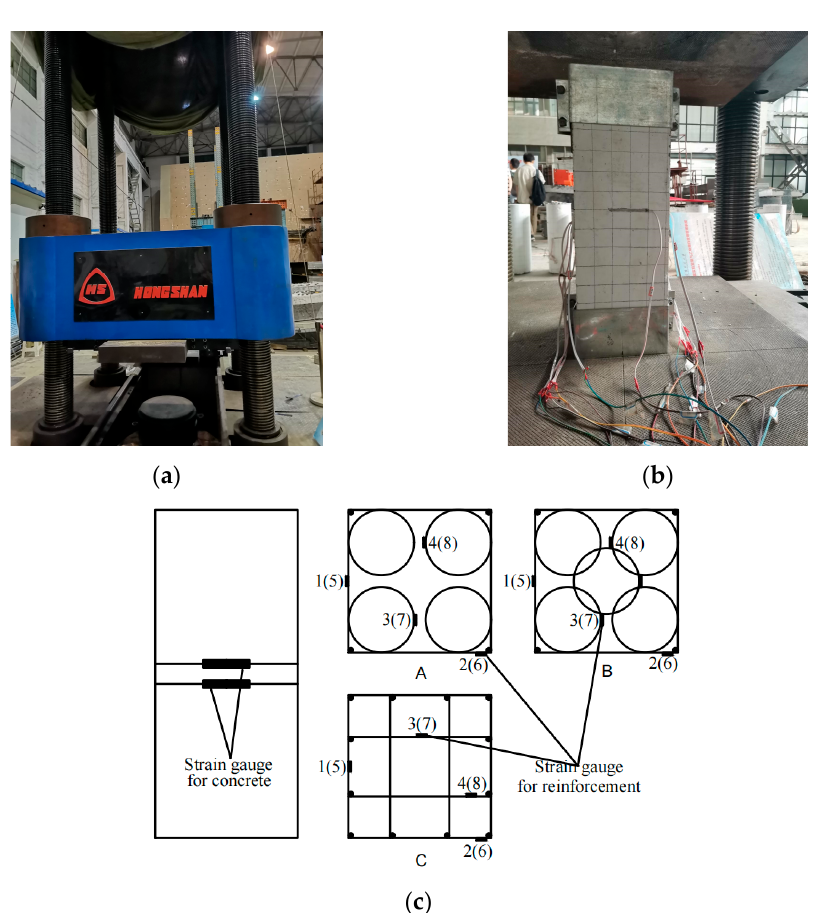
Figure 3. Distribution of loading device and measuring point. ( a ) 2000 KN hydraulic test machine; ( b ) Tested specimen; ( c ) Distribution of strain gauge.